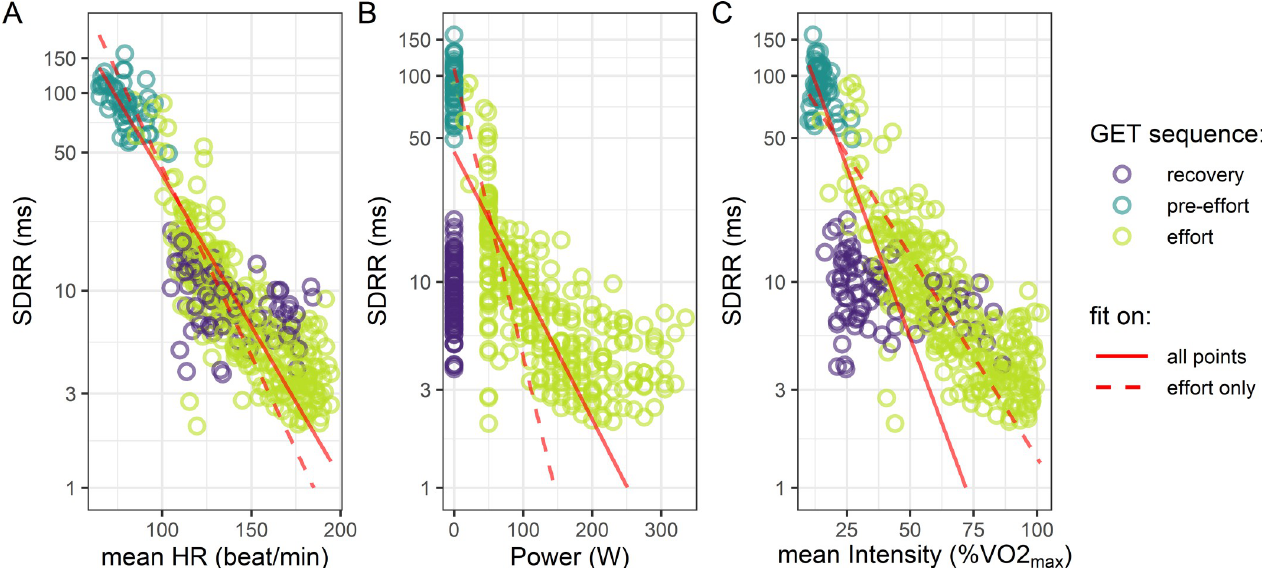
Fig 3. Different representations of HRV during effort. SDRR of the detrended RR time series recorded during a graded effort test as a function of: A) the mean heart rate (HR) during the interval, B) the work load during the exercise test and C) the mean work intensity. The color of the points indicates the SDRR was calculating on RR before (pre-effort), during (effort), or after (recovery) the effort. The solid red line corresponds to the regression estimate obtained on the entire set of SDRR values using model 1, 2 and 3 of Eq 2 in A, B, and C, respectively, and dashed red lines are the regression estimate obtained on SDRR values during effort only (i.e. excluding pre-effort and recovery periods) using model 1, 2 and 3 of Eq 2 in A, B, and C,